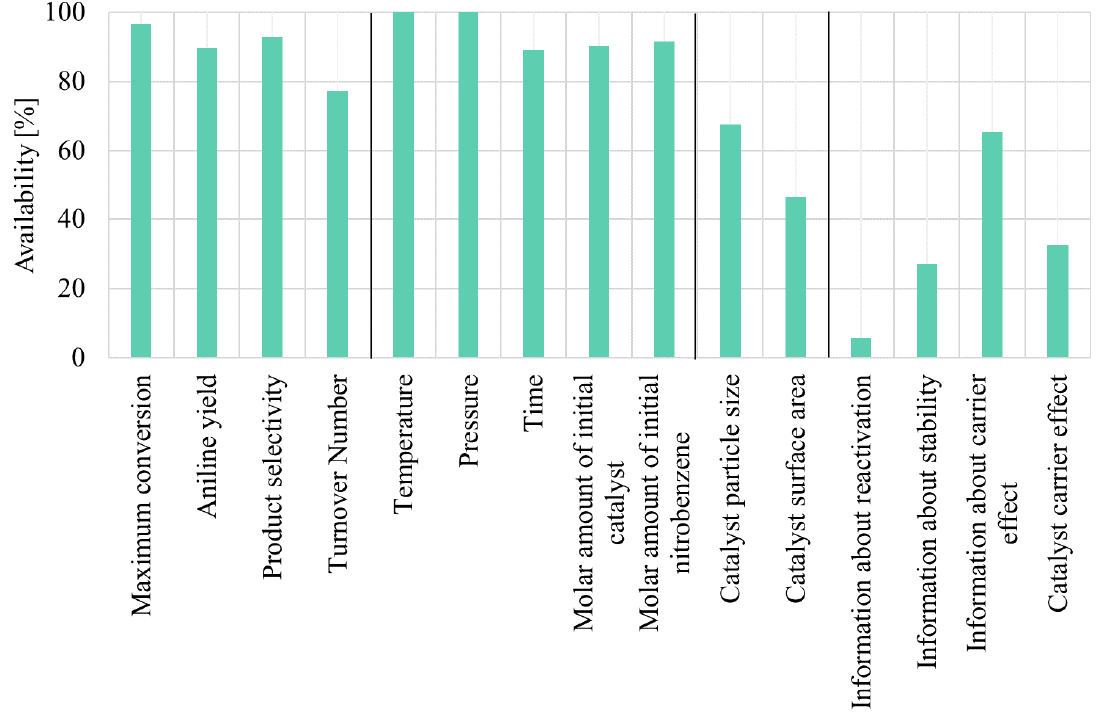
Figure 7. Relative frequency of data occurrence according to MIRA 21 descriptors.